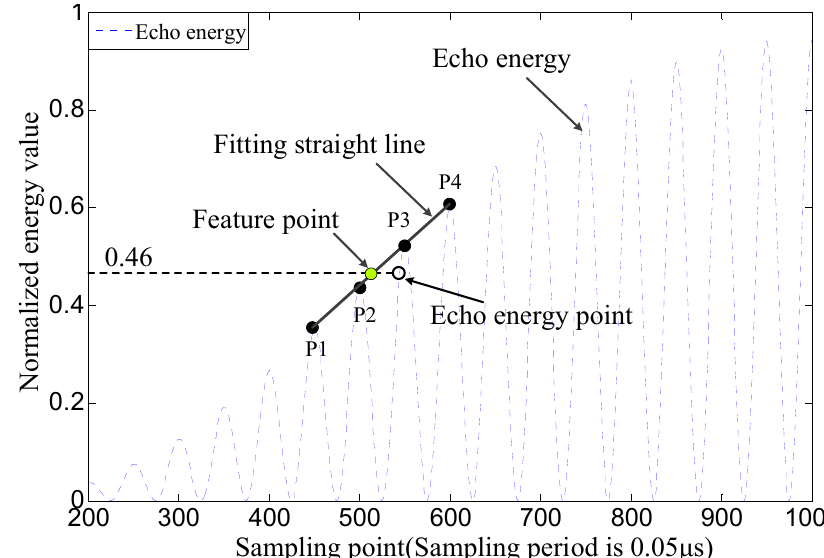
Figure 2. The simulation of the energy peak fitting method.